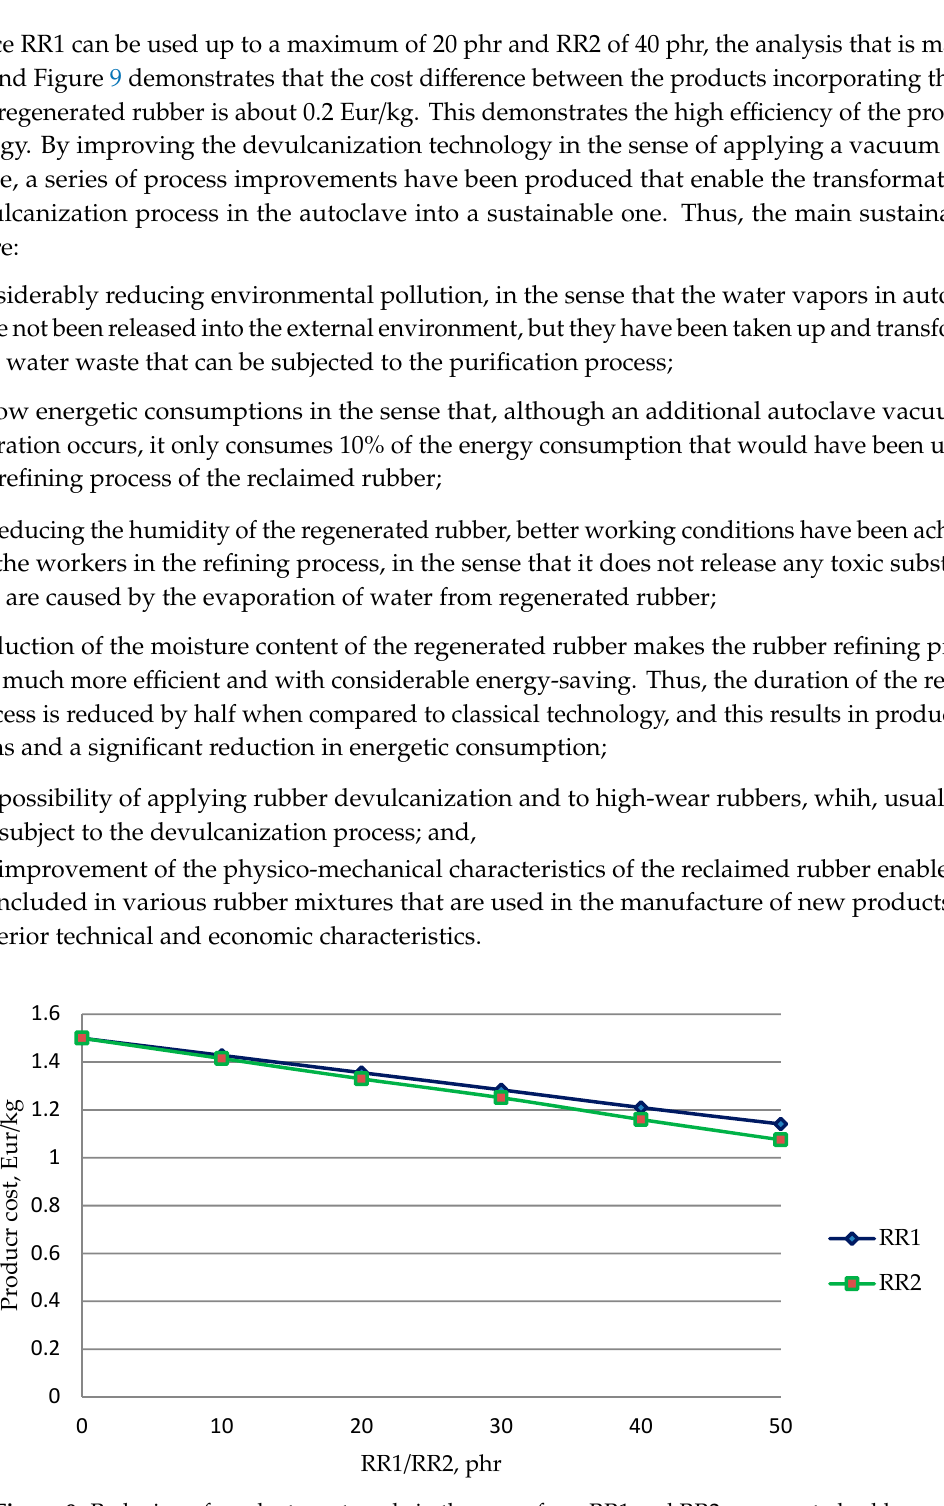
Table 9. The products cost made using RR1 and RR2 regenerated rubber, Eur/kg.